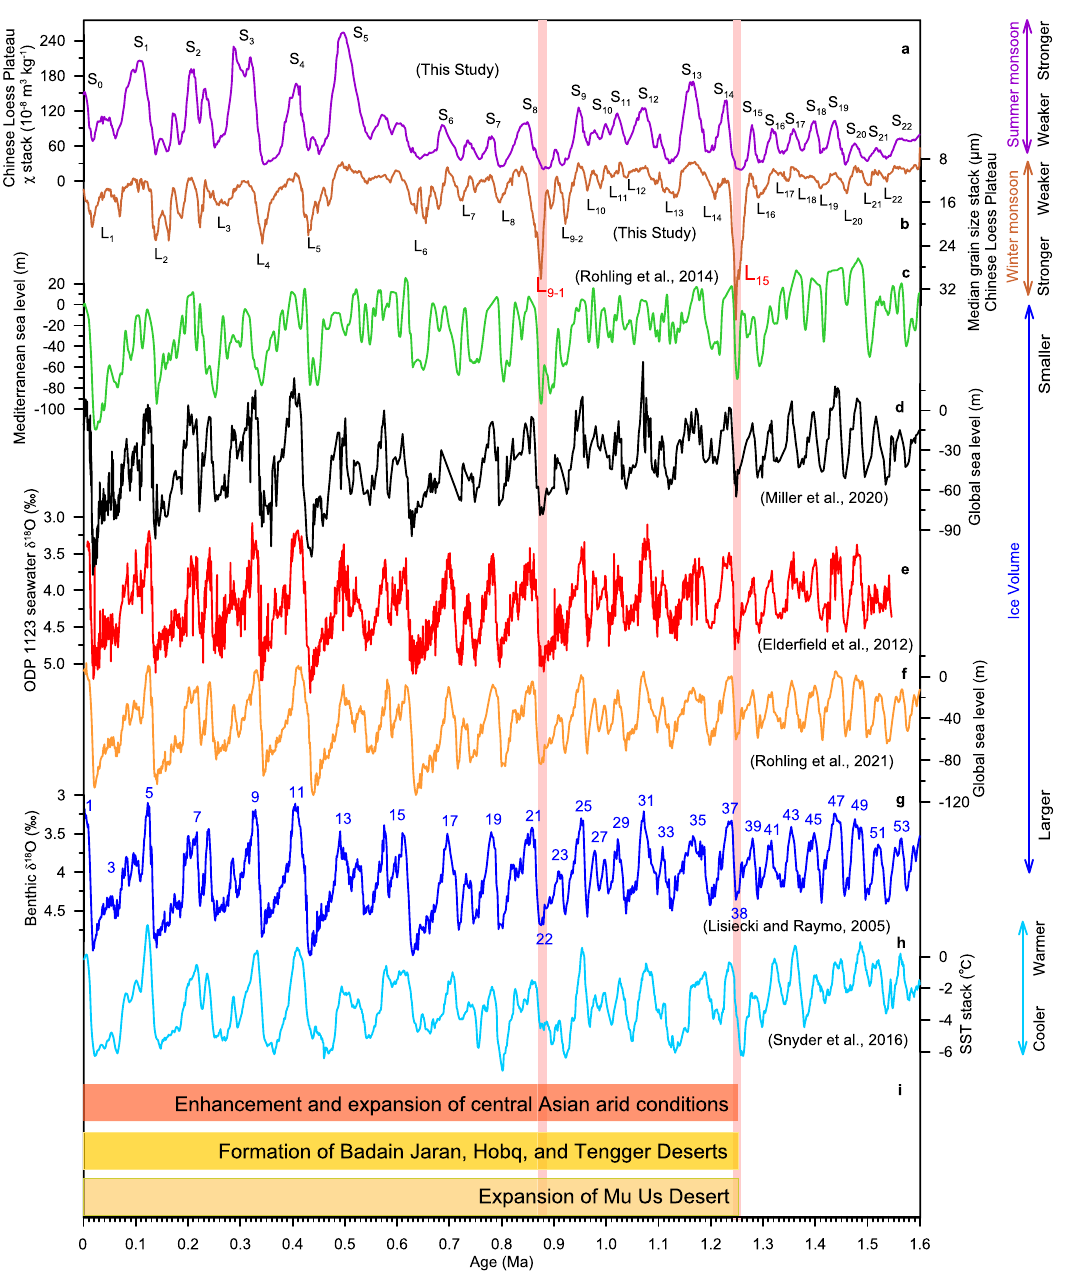
Fig. 4 Terrestrial and global climate variability on glacial-interglacial timescales across the mid-Pleistocene transition. Our newly established Chinese Loess Plateau a χ and b median grain size stacks. S-numbers and L-numbers refer to consecutive palaeosol and loess horizons counting back from the present day, respectively. c Mediterranean sea level record 8 , d Global sea level reconstruction based on Paci fi c benthic foraminiferal δ 18 O and Mg/Ca stack 6 . g LR04 benthic foraminiferal δ 18 O record 47 . Numbers refer to Marine Isotope Stages, counting back from the present day. h global average sea surface temperature (SST) stack 70 . i Enhanced Asian aridi fi cation, new desert formation, and desert expansion from ~1.25 Ma onward inferred from geological records 19,28,32,56,58,59 . Pink bars indicate the correlation of coarse marker loess layers (L 15 and L 9-1 ) to glacial stages (marine isotope stages 38 and